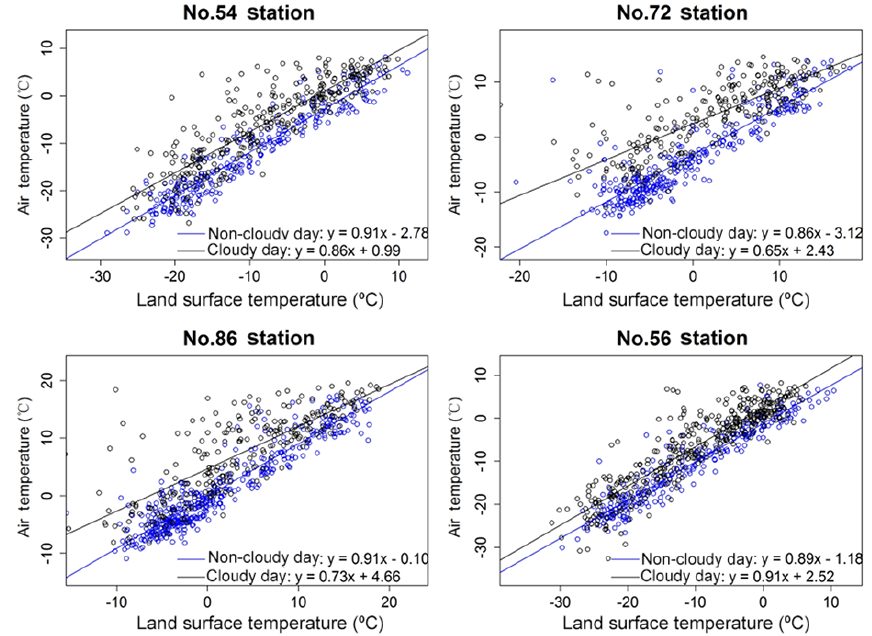
Figure 12. Comparisons of T min estimation accuracy between “cloudy day” and “non-cloudy day” conditions at four meteorological stations presenting the largest decline in